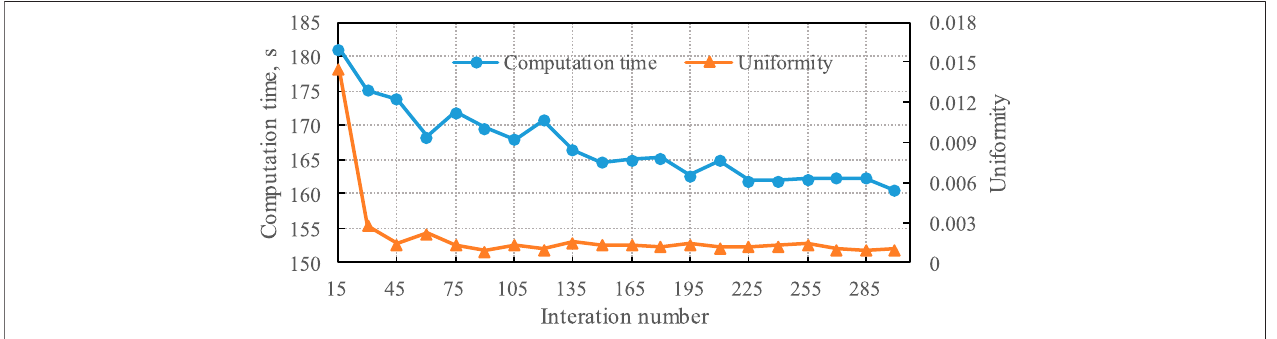
FIGURE 8 | Impacts of iteration generation on computation time and uniformity of solutions.